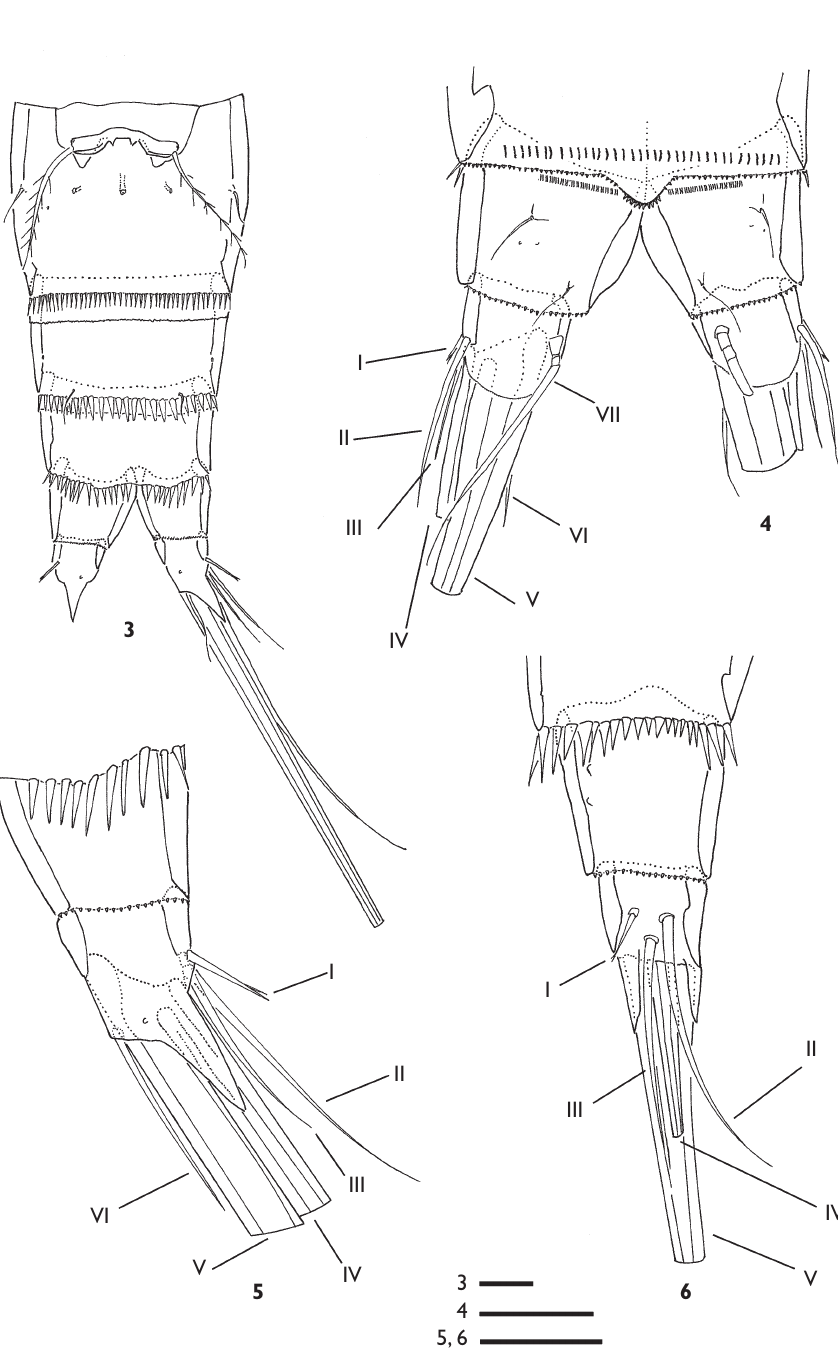
Figures 3-6. Chaulionyx paivacarvalhoi gen. et sp. n. ♀ : 3 urosome, ventral [segment bearing P5 omit- ted] 4 caudal rami, dorsal 5 left caudal ramus, ventral 6 left caudal ramus, lateral. Scale bars = 10